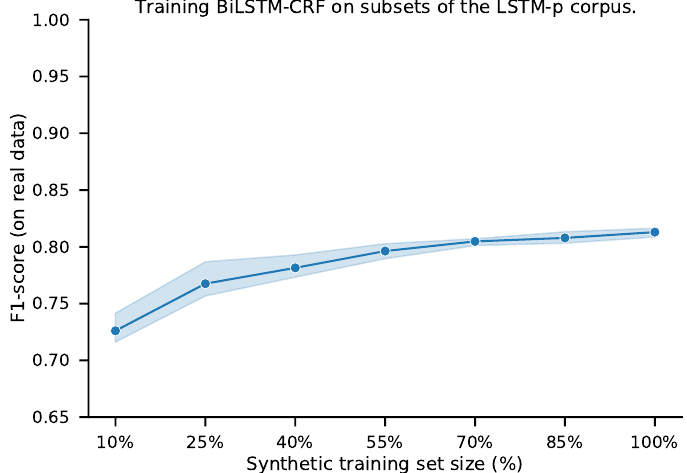
Figure A3. Entity-level F1-score for varying LSTM-p training set sizes. The full training set (100%) consists of all training and validation documents in LSTM-p. The F1-score is measured on the NUT test set. For each subset size, we train/test each model 3 times. The line shows the averaged scores along with the 95% confidence